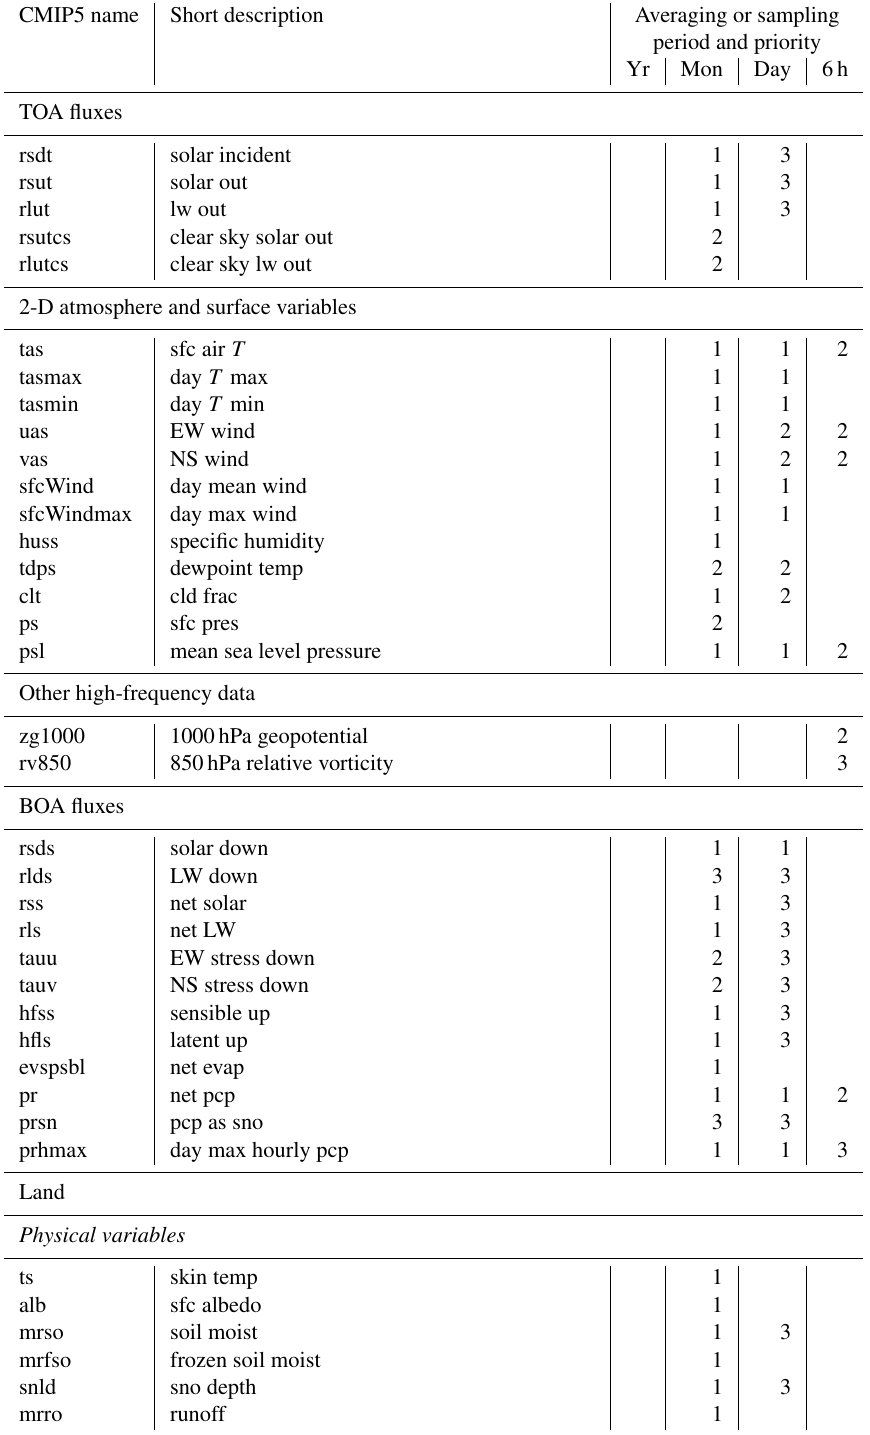
Table D1. DCPP Data Retention